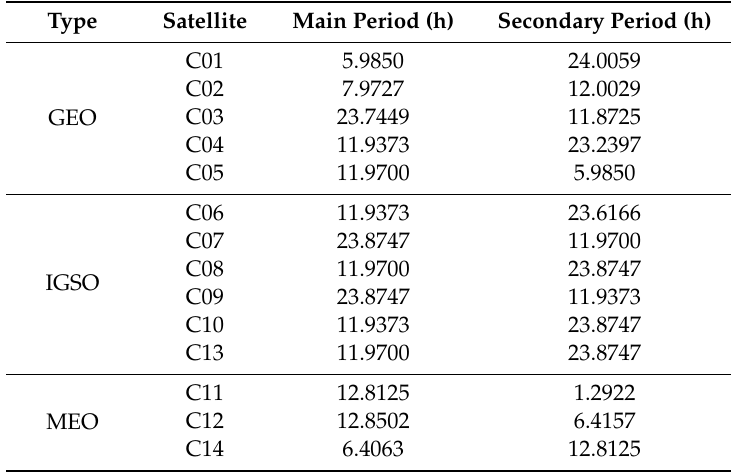
Table 1. BDS-2 satellite clock periodic terms